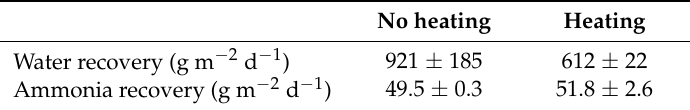
Figure 4. TAN concentration in the acid tank ( (cid:4) ) and weight of the acidic solution ( ) during the experimental time. The error bars represent the standard deviation of duplicate experiments. Table 4. Effect of heating the acidic solution (3 °C warmer than wastewater in the reactor) on the recovery of both water and ammonia. Data are means of duplicate experiments ± standard deviations.